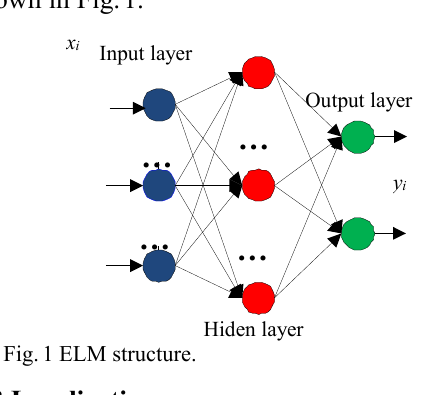
Fig. 1 ELM structure.